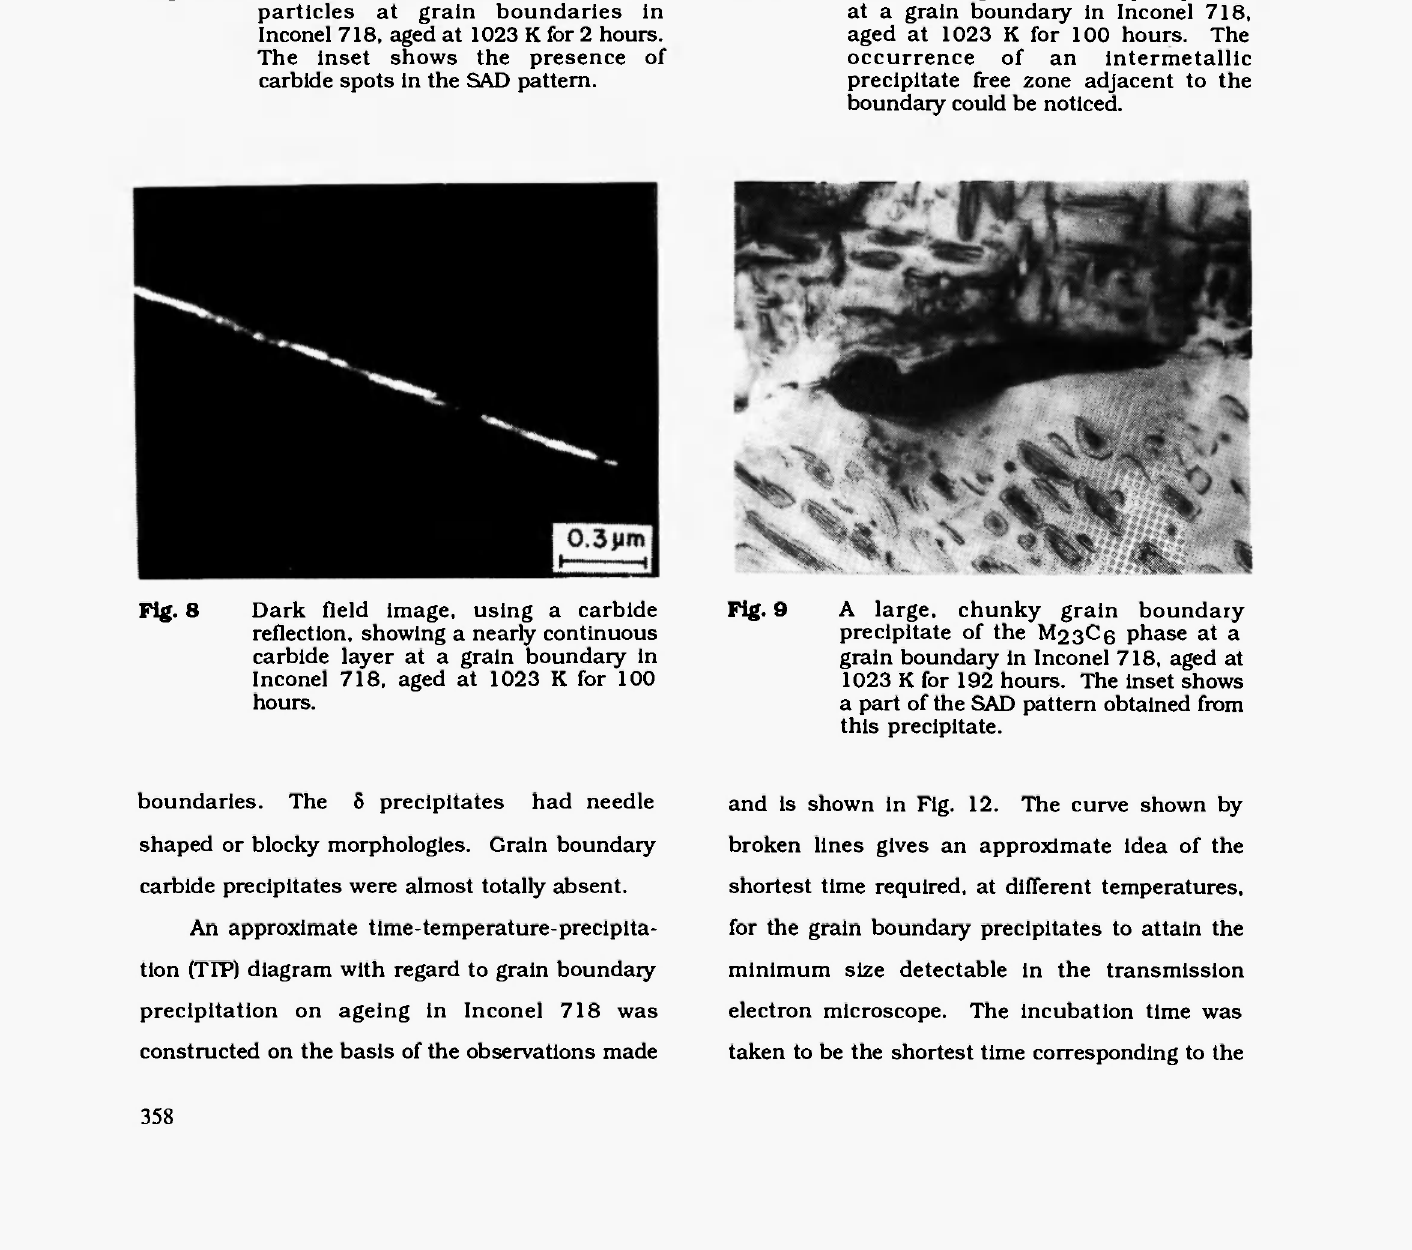
Fig. 6 Precipitation of discrete carbide particles at grain boundaries in Inconel 718, aged at 1023 Κ for 2 hours. The inset shows the presence of carbide spots in the SAD pattern.